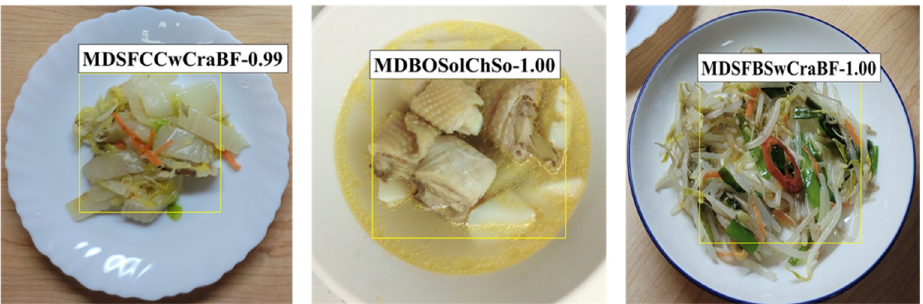
Figure 10. Recognition results for different types of mixed dishes.